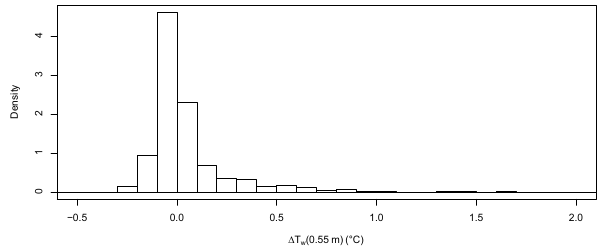
Figure 8. Histogram of (cid:49)T w (0.55m) at the reservoir of Bimont at 10:00UTC, 21 February 2014 to 24 April